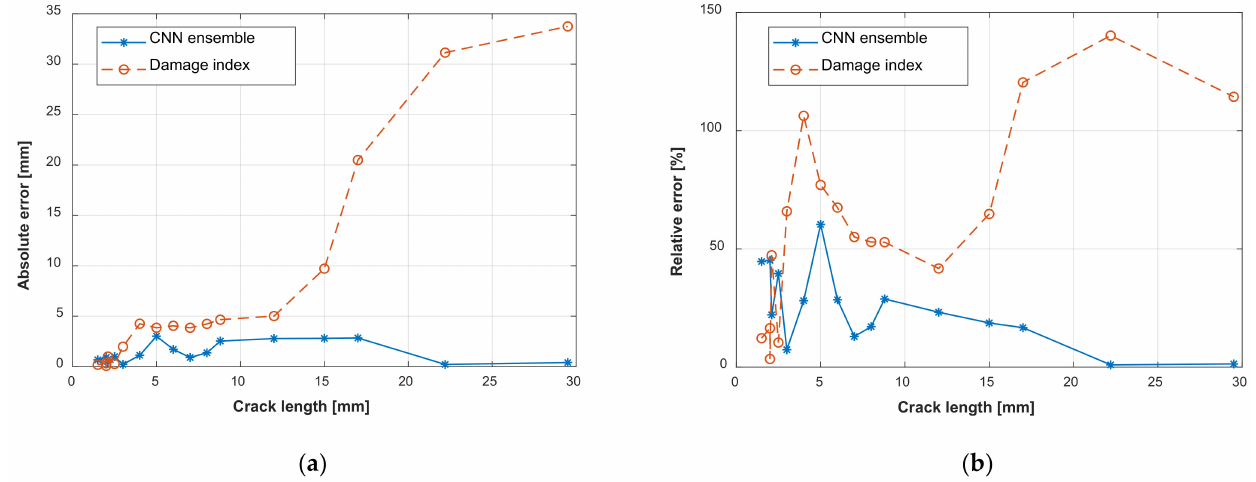
Figure 18. Fatigue crack evaluation errors: ( a ) Absolute error; ( b ) Relative